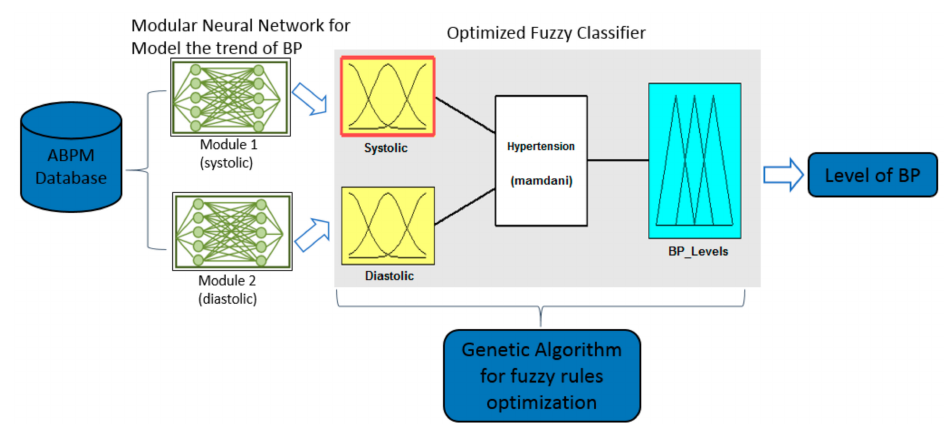
Figure 2. Specific Neuro Fuzzy Hybrid